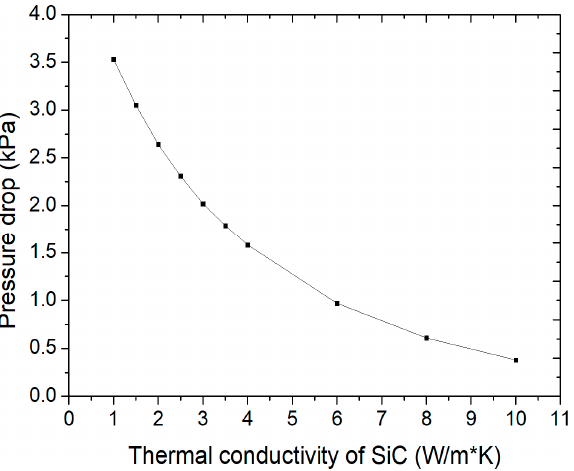
Figure 9. Variation of pressure drop for different thermal conductivity of SiC.